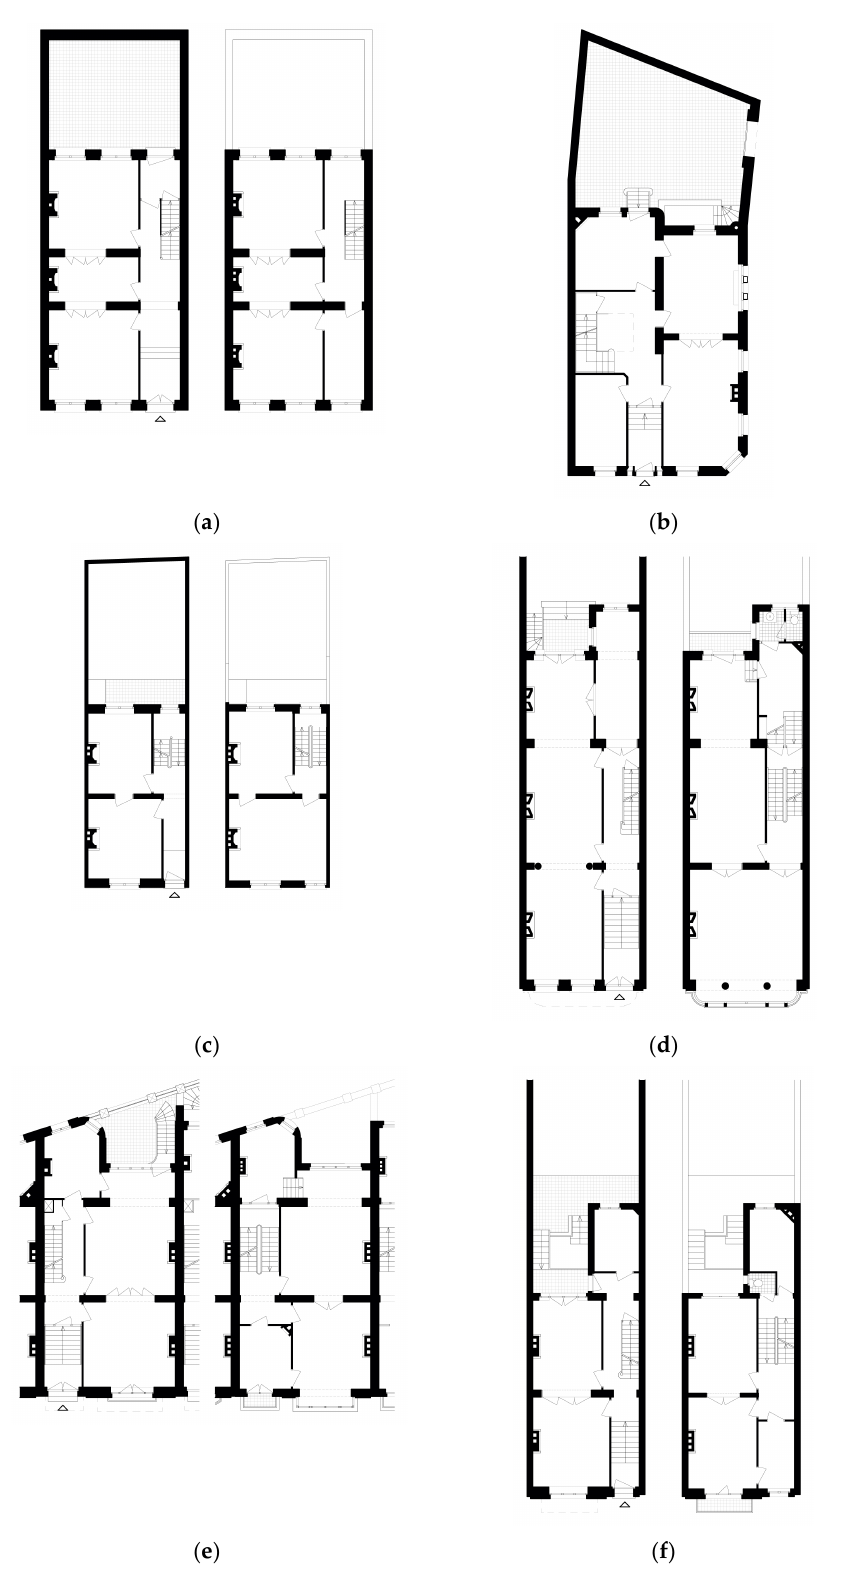
Figure 2. Dwelling plans of selected Brussels referential types (re-drawings by the authors): ( a ) François- Tilman Suys, Leopold Block (1837); ( b ) Victor Taelemans, rue Philippe Le Bon 70 (1901); ( c ) un- known architect, rue des Perdrix 33 (1908); ( d ) François Hemelsoet, Boulevard Lambermont 73 (1908); ( e ) J. Michiels, rue des Commerçants 6 (1911); ( f ) unknown architect, avenue Jules de Trooz 12